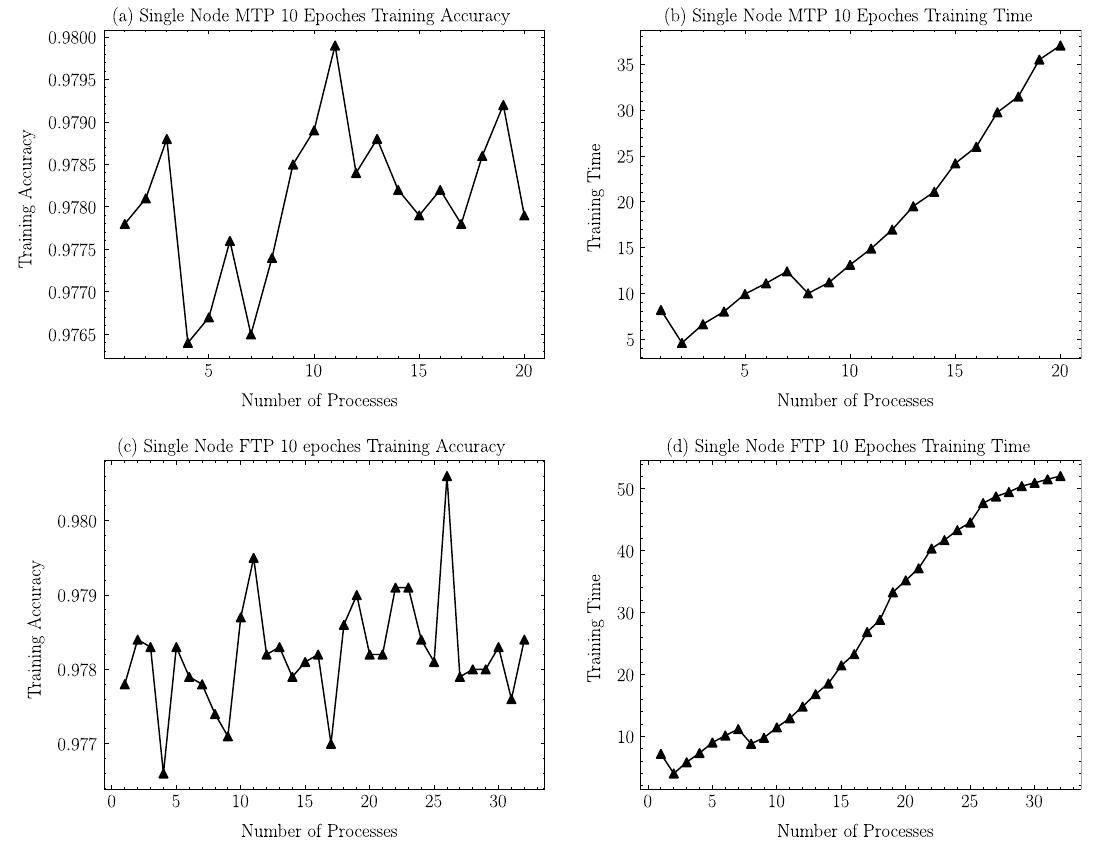
Figure 6. MT2000+ and FT2000+ single node training accuracy and training